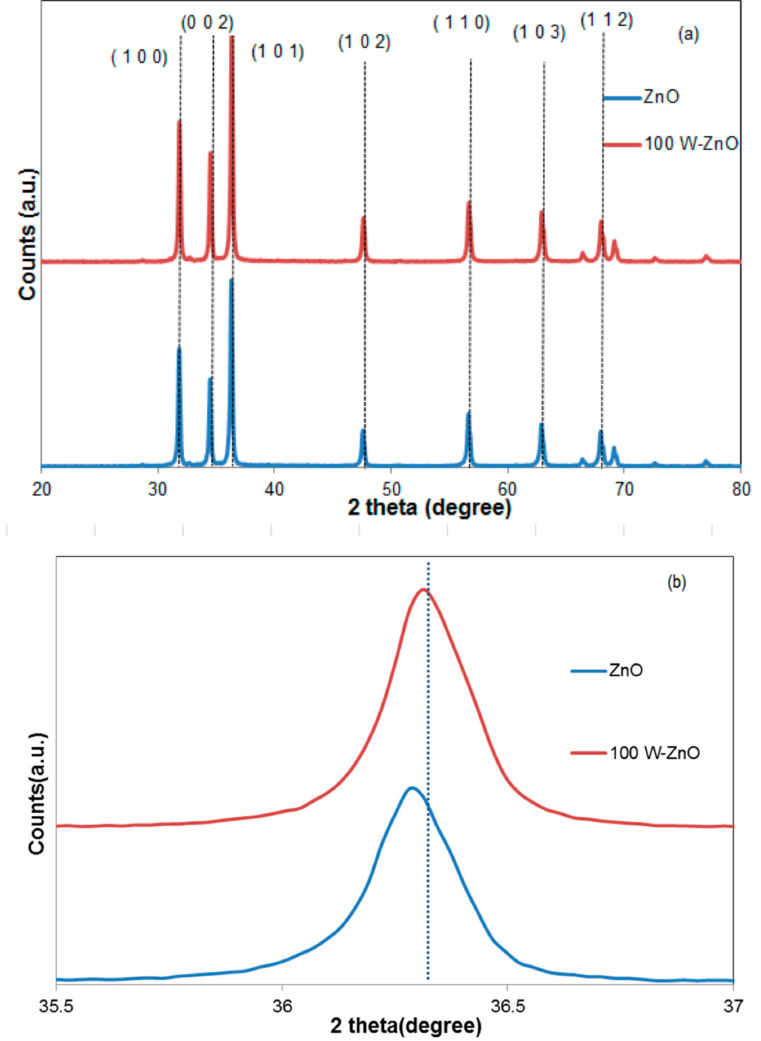
Figure 4. XRD patterns of undoped ZnO and W-doped ZnO photocatalysts in the range 20–80 ◦ ( a ) and in the range 35.5–37 ◦ ( b